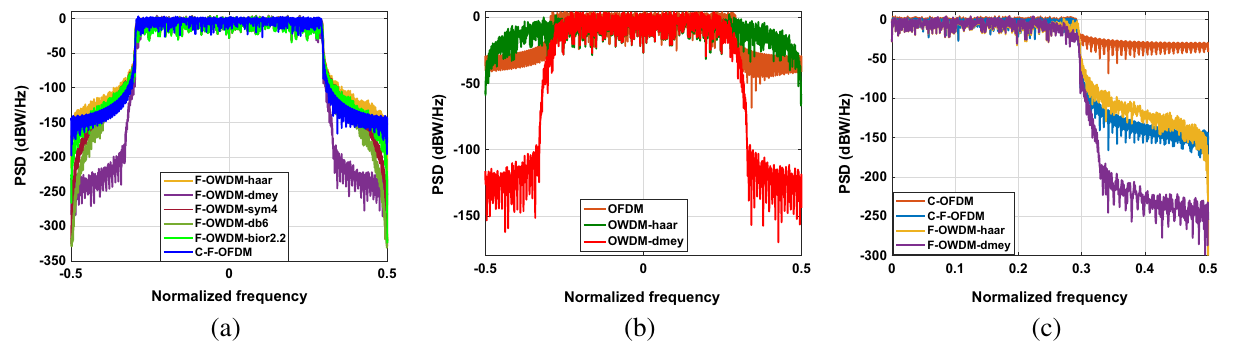
Figure 6. ( a ) Comparison of PSDs of the proposed F-OWDM technique using different wavelets. ( b ) comparison of PSDs of dmey -OWDM and haar -OWDM with C-OFDM. ( c ) comparison of PSDs of dmey -F- OWDM and haar -F-OWDM with C-F-OFDM.